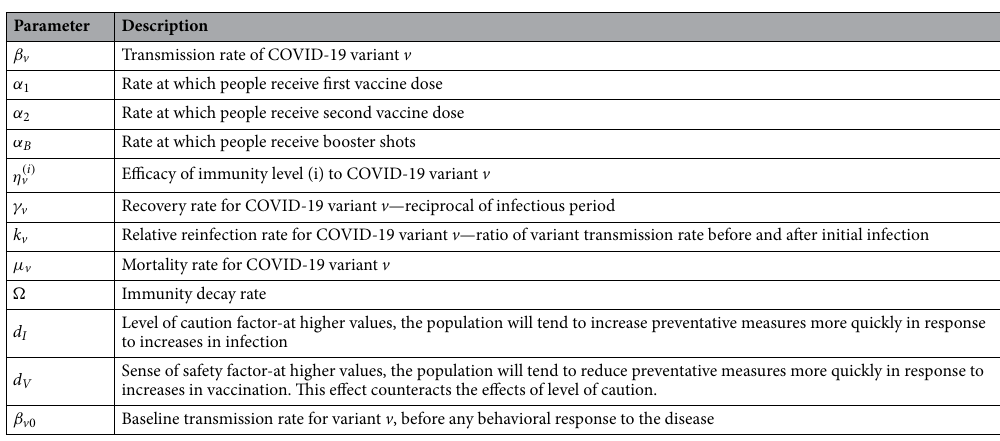
Table 1. Parameters in the model and their physical